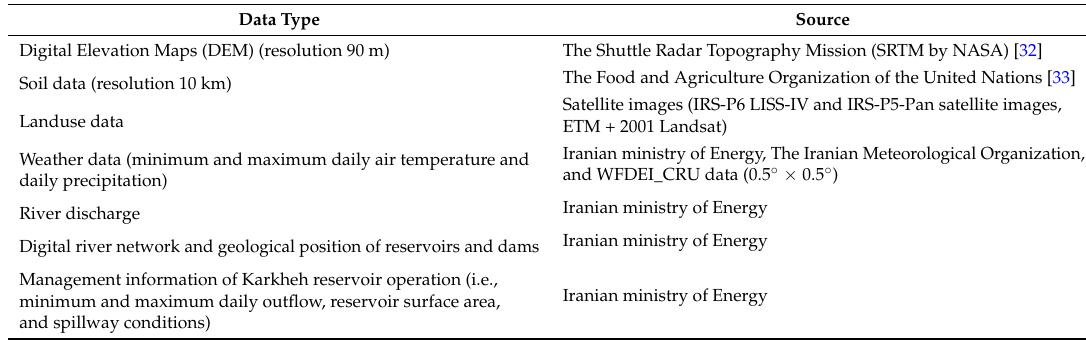
Table 2. Data description and sources used in the SWAT projects.